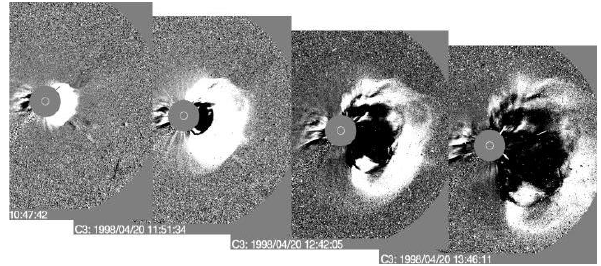
Figure 8. The extremely fast partial halo limb CME of 20 April 1998 (E58) was associated with a M1.6 flare not far behind the west limb. The images are running differences between LASCO C3 images. The expansion angle was about 180 0 . The expansion speed was 1930 km/s, the plane of the sky speed was 1944 km/s. A shock arrived at the Earth 79.1 hours later, i.e., about 24 hours later than we predicted. A moderate magnetic storm (D st –59 nT) peaked 13 hours after shock arrival.